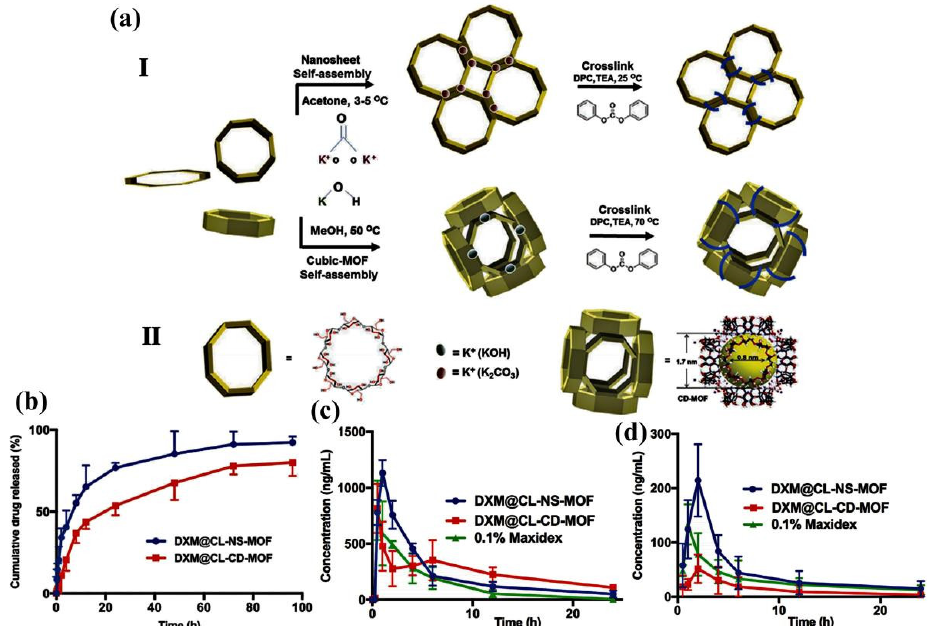
Figure 10. ( a ) NS- and CD-MOFs with an effective carbonyl crosslink. ( b ) Drug-release curves